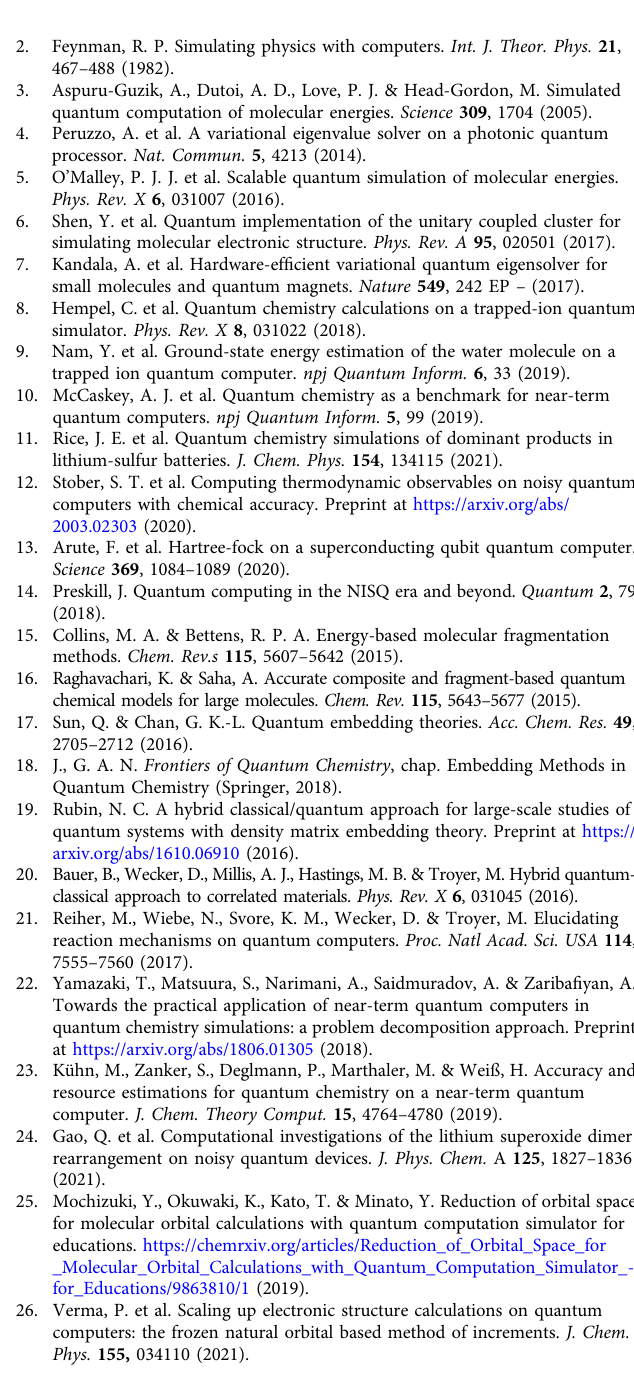
Fig. 3 Circuit optimization. The rules used to optimize the qubit coupled-cluster circuits for the ion trapped